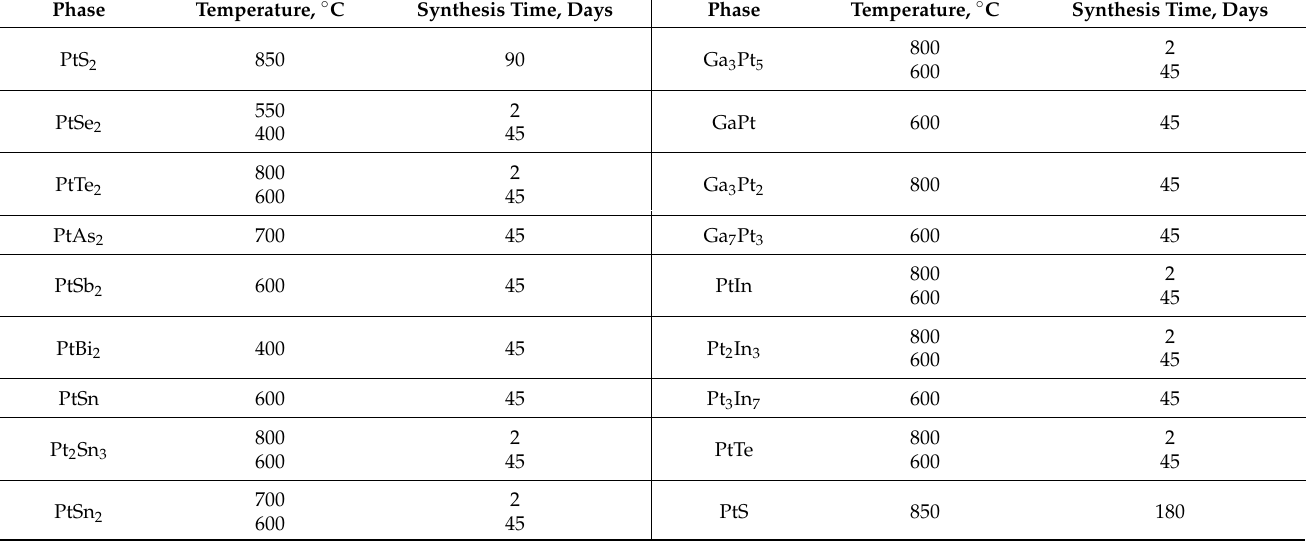
Table 1. Temperature and duration of synthesis of 18 Pt-bearing phases. The two temperatures for one substance correspond to the two-stage synthesis